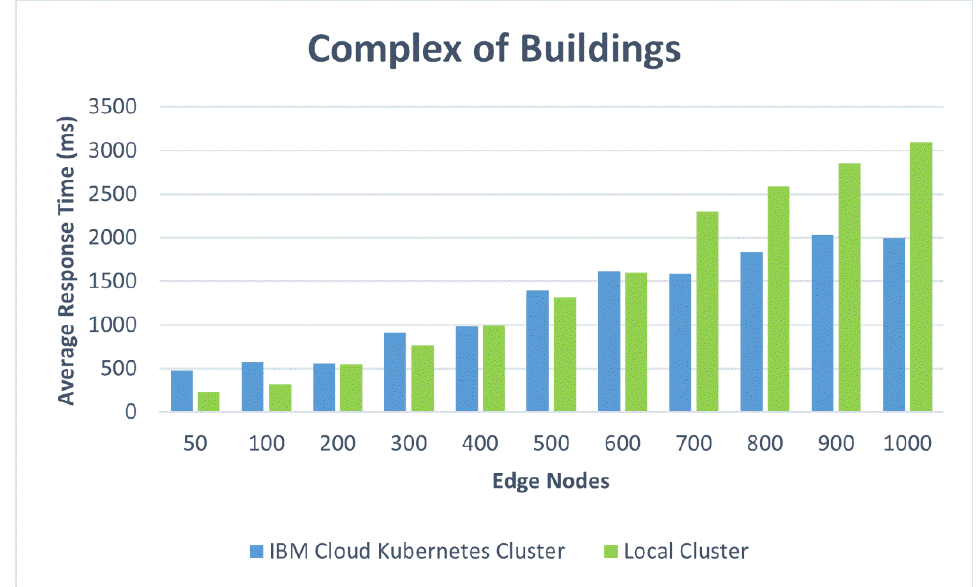
Figure 13. Comparative response times for the complex of buildings.